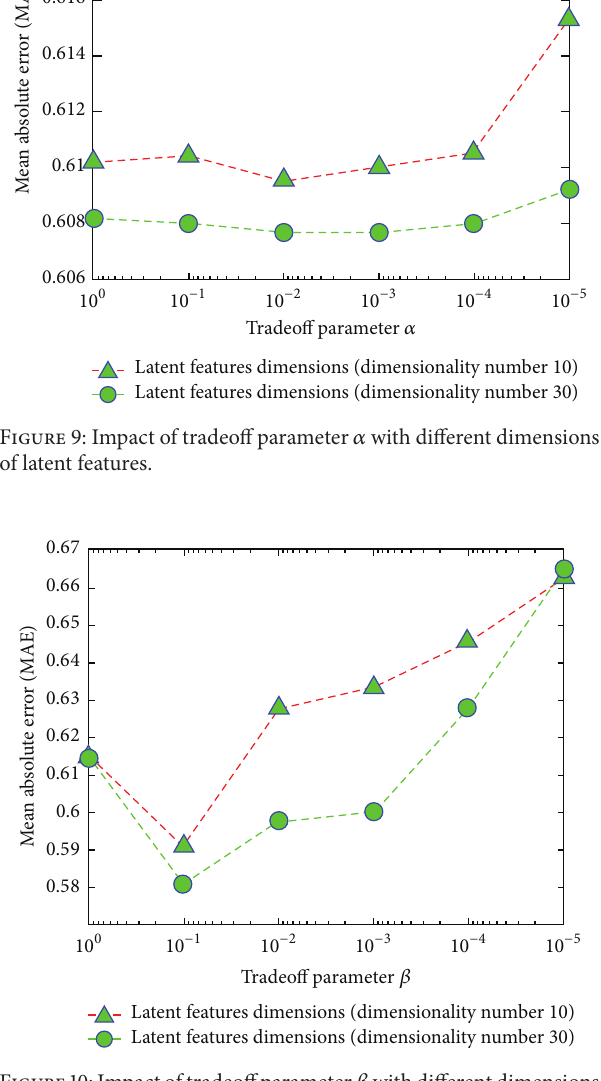
Figure 10: Impact of tradeoff parameter 𝛽 with different dimensions of latent